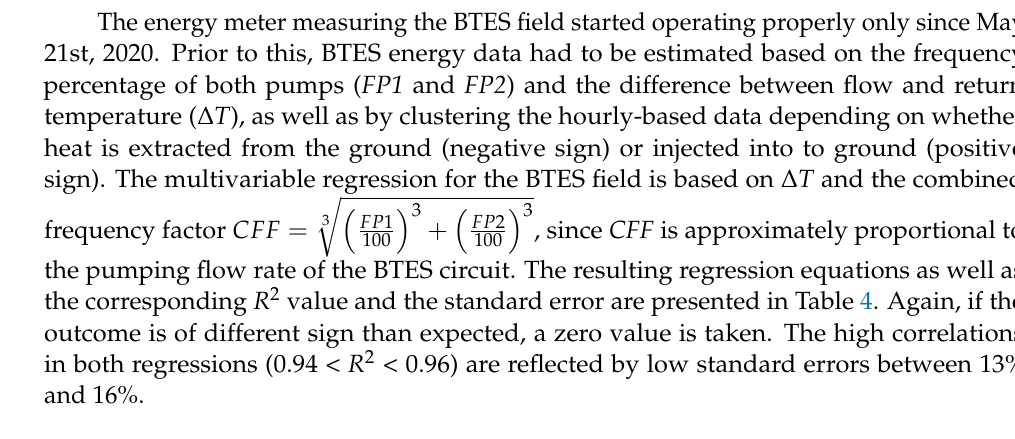
Table 4. BTES field and dissipation: Parameters for regression models and